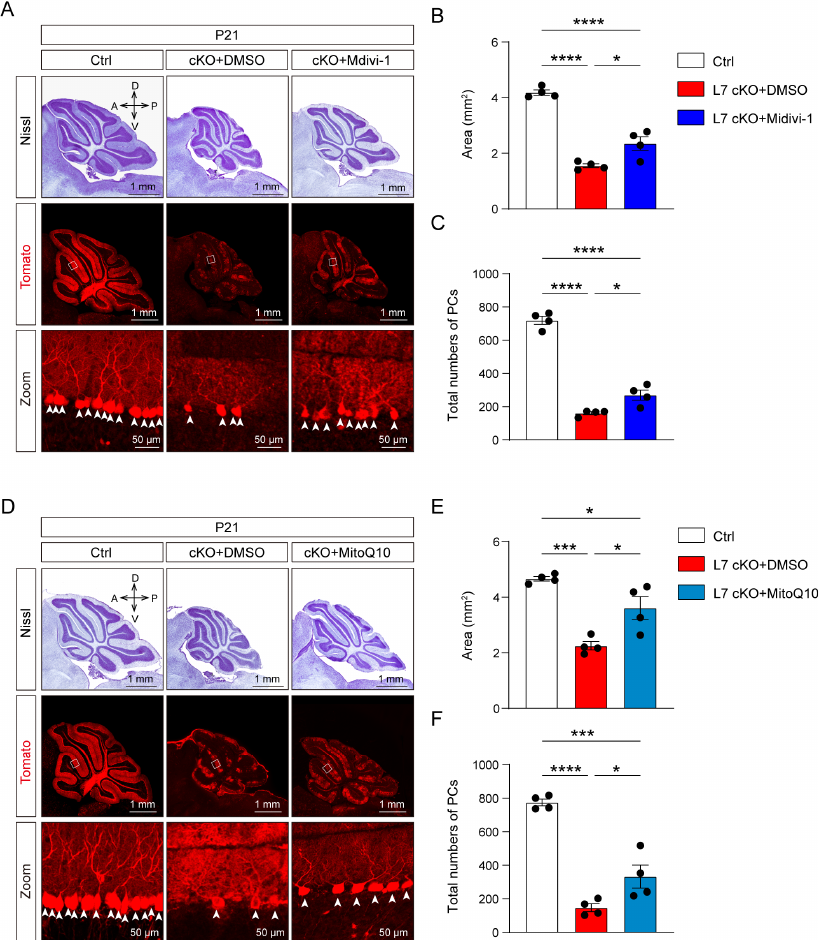
Figure 6. Suppression of ROS production significantly rescue cerebellar PC loss in cKO mice. ( A ) Nissl staining of sagittal histological sections of the cerebellar vermis and immunofluorescent image of Tomato (red) staining to reveal PCs in the cerebellar vermis of the Ctrl and cKO mice treated with DMSO or the cKO mice treated with Midiv-10 (scale bar: 1 mm, 50 µ m). ( B ) Quantification of the area of sagittal sections of the cerebellar vermis from the Ctrl and cKO mice (mean ± SEM; **** p < 0.0001, * p < 0.05, n = 4). ( C ) The number of PCs per sagittal histological section of the cerebellar vermis from the Ctrl and cKO mice (mean ± SEM; **** p < 0.0001, * p < 0.05, n = 4). ( D ) Nissl staining of sagittal histological sections of the cerebellar vermis and immunofluorescent image of Tomato (red) staining to reveal PCs in the cerebellar vermis of the Ctrl and cKO mice treated with DMSO or the cKO mice treated with MitoQ10 (scale bar: 1 mm, 50 µ m). ( E ) Quantification of the area of sagittal sections of the cerebellar vermis of the Ctrl and cKO mice (mean ± SEM; *** p < 0.001, * p < 0.05, n = 4). ( F ) The number of PCs per sagittal histological sections of the cerebellar vermis of the Ctrl and cKO mice. (mean ± SEM; **** p < 0.0001, *** p < 0.001, * p < 0.05, n = 4). a, anterior; d, dorsal; p , posterior; v,